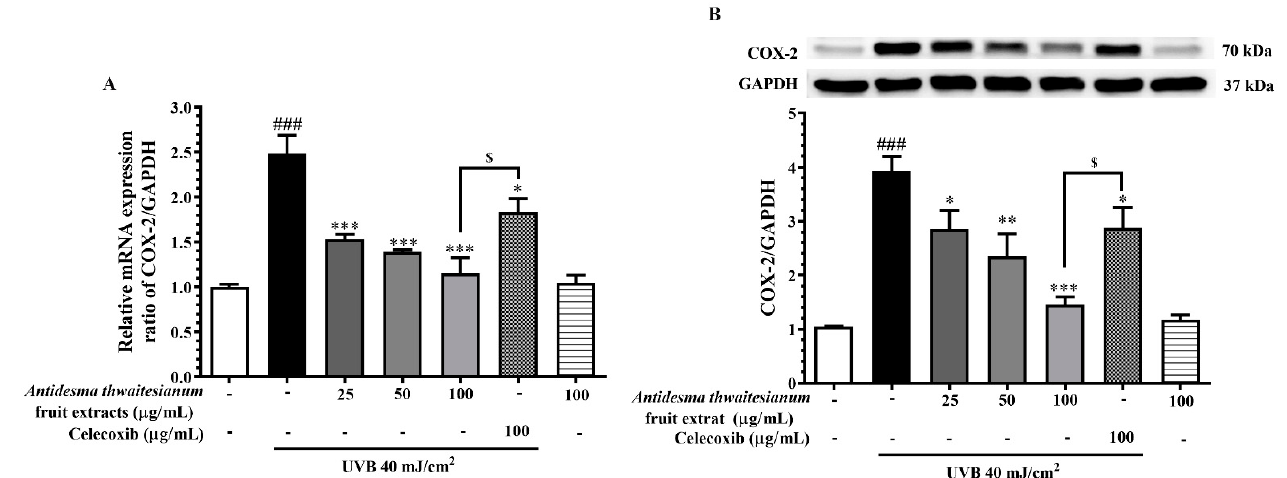
Figure 7. The alterations of ( A ) mRNA and ( B ) protein expression levels of COX-2 upon treatment with various concentrations of the fruit extract. Cells were pre-incubated with the fruit extract before exposure to single UVB irradiation and further incubated for 24 h. The mRNA was determined by real-time PCR and the proteins were determined by Western blot analysis. The results are presented as mean ± SEM (n = 6) and analyzed with Tukey’s test. ### p < 0.001 versus the control group; * p < 0.05, ** p < 0.01, and *** p < 0.001 versus UVB-irradiated cells alone. The statistical difference between the extract and celecoxib at 100 µg/mL was $ p < 0.05.